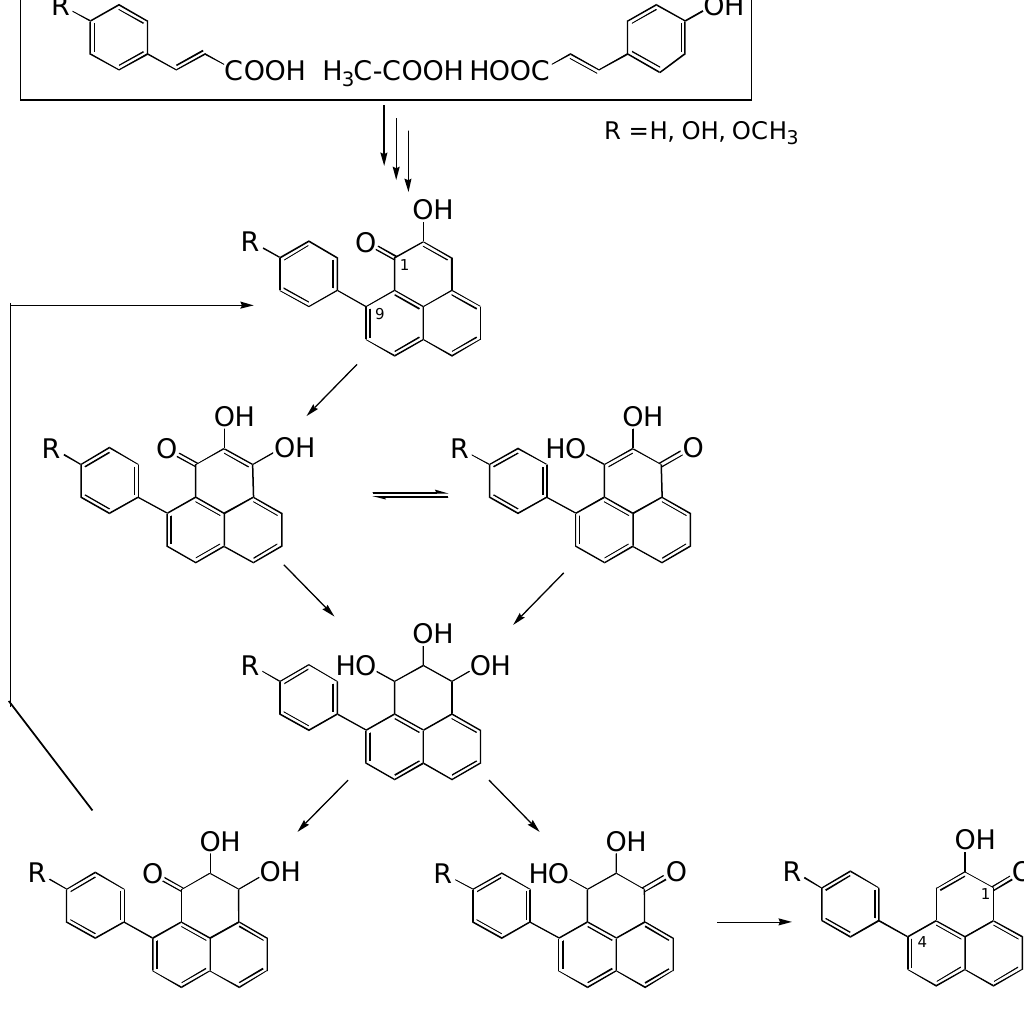
Figure 3. Hypothetical biogenetic pathways to phenylphenalenones in Musa